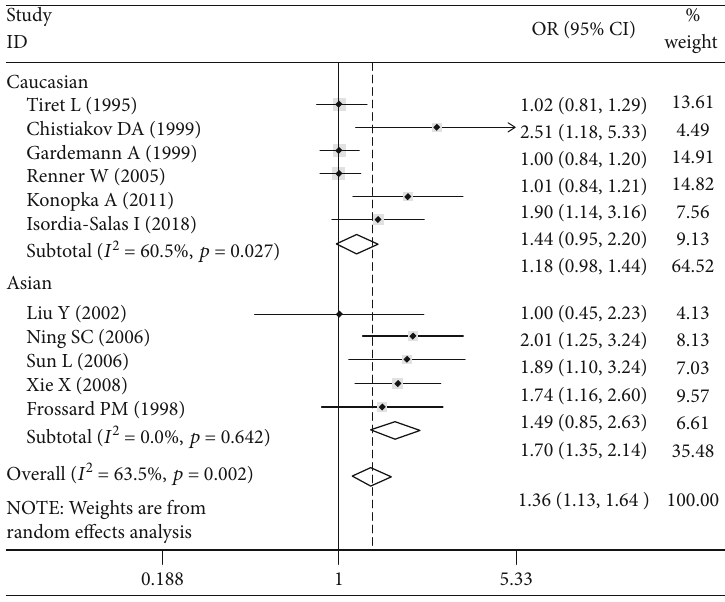
Figure 4: Forest plot of AGT p.Thr174Met polymorphism associated with myocardial infarction strati fi ed by ethnicity using an additive genetic model (M vs. T).